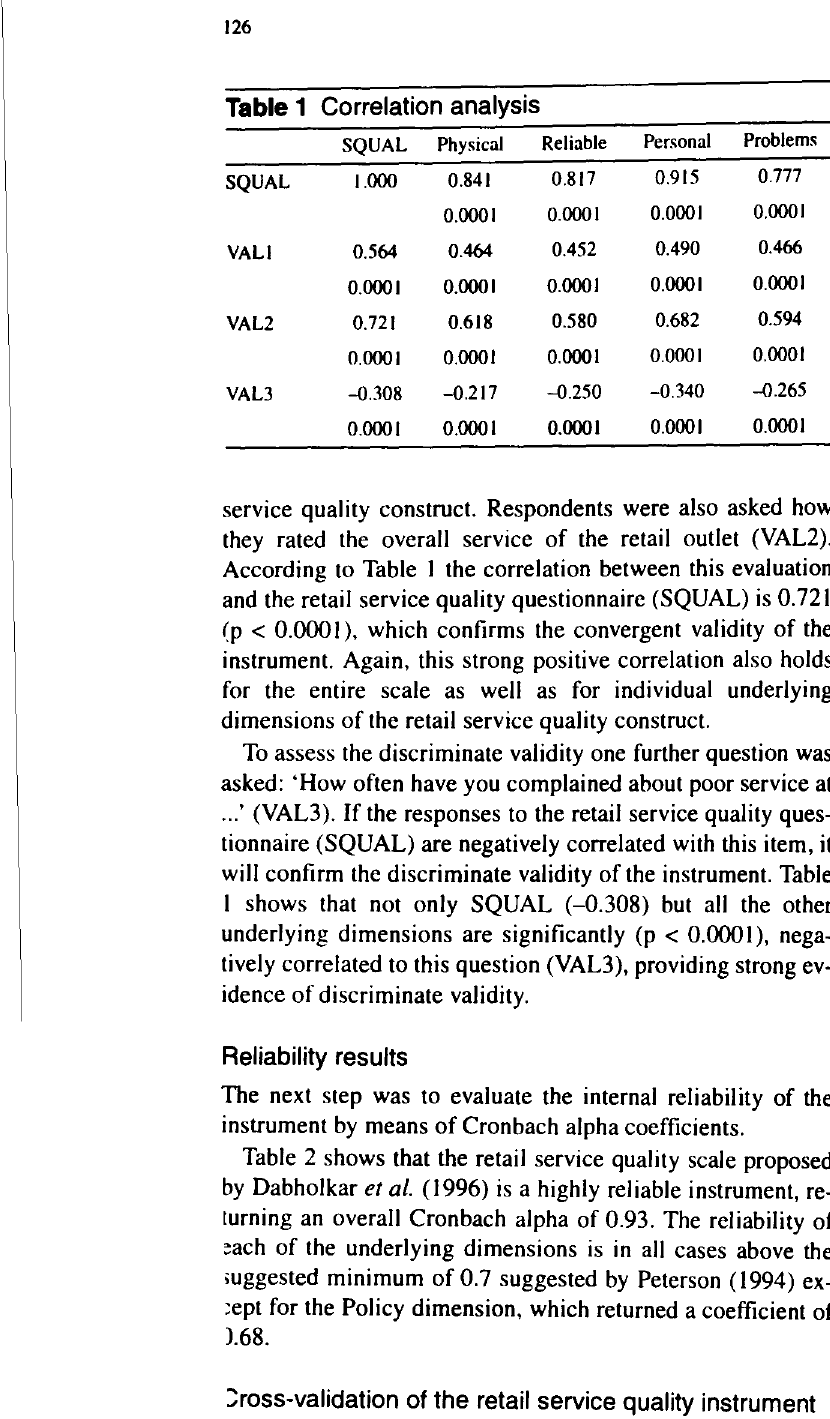
Table 2 Reliability results